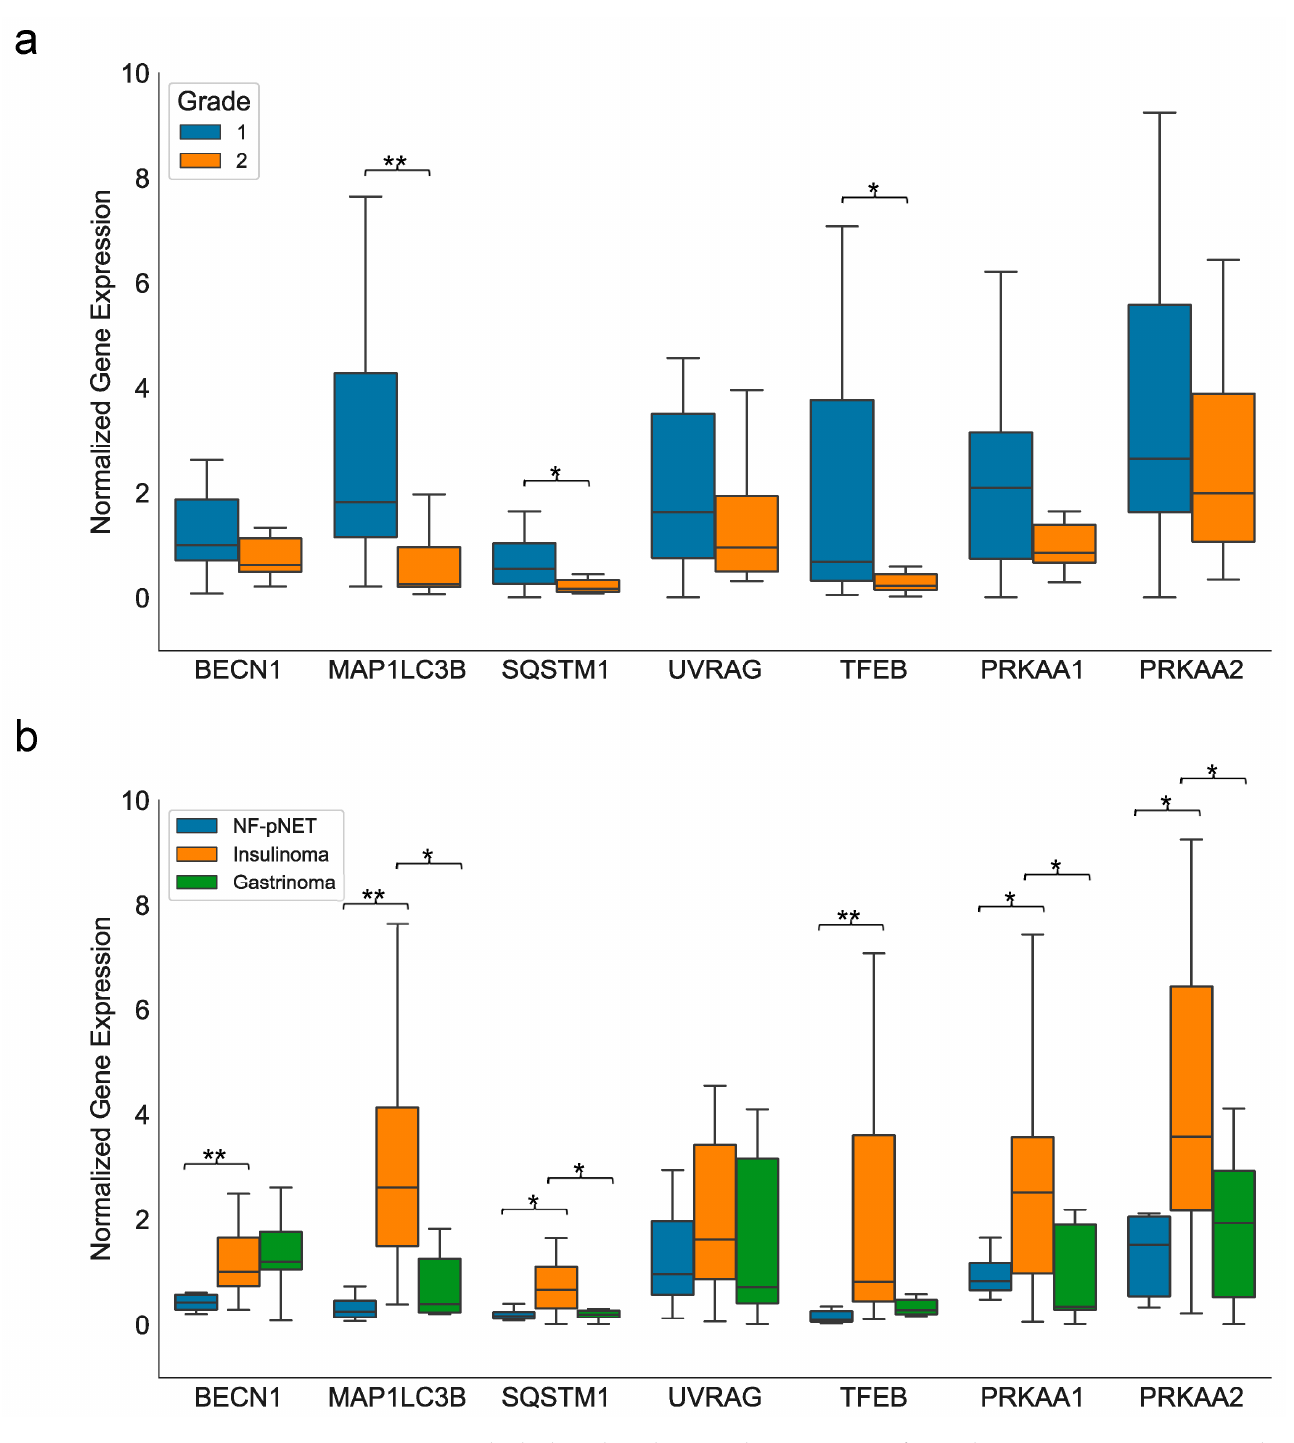
Figure 3. Box and whisker plots showing the expression of autophagic gene transcripts according to grading ( a ) or functionality ( b ) of sporadic pNETs; * p < 0.05 and ** p < 0.001 were considered